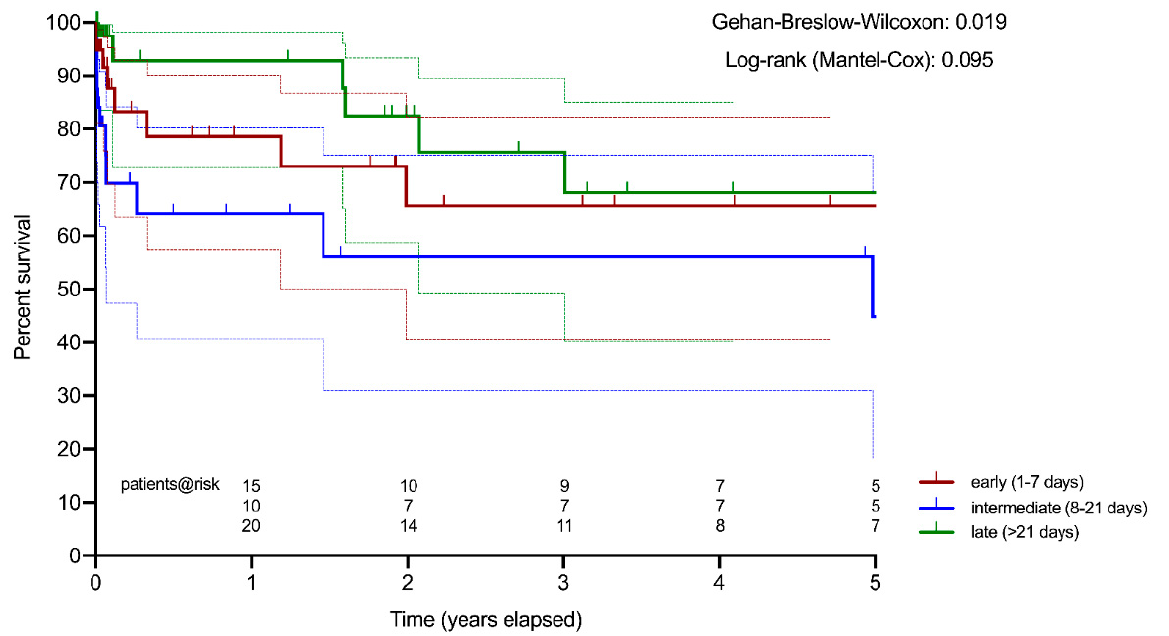
Figure 1. Actuarial survival estimation (Kaplan–Meier): early surgery (red) vs. intermediate surgery (blue) vs. late surgery (green).